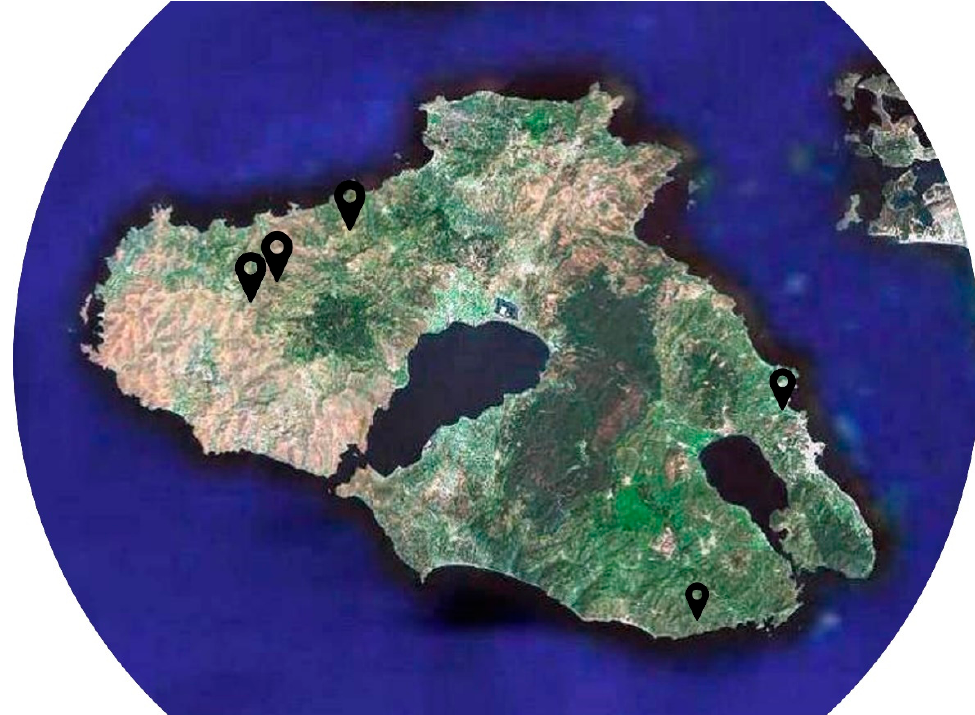
Figure 1. Operating wineries in Lesvos island.